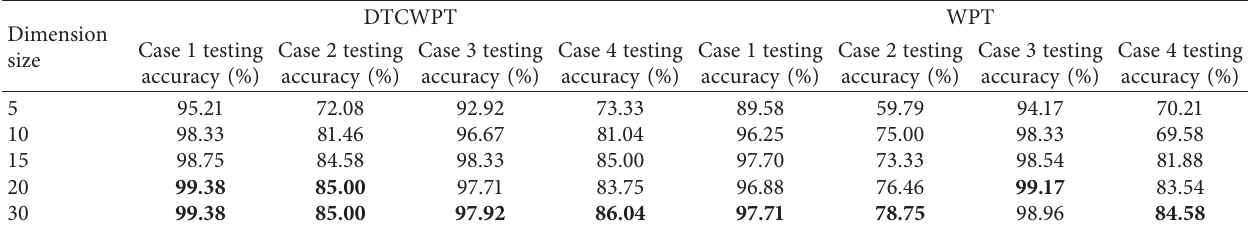
Table 6: Bearing fault diagnosis results obtained by OFS-PCA-SVM.